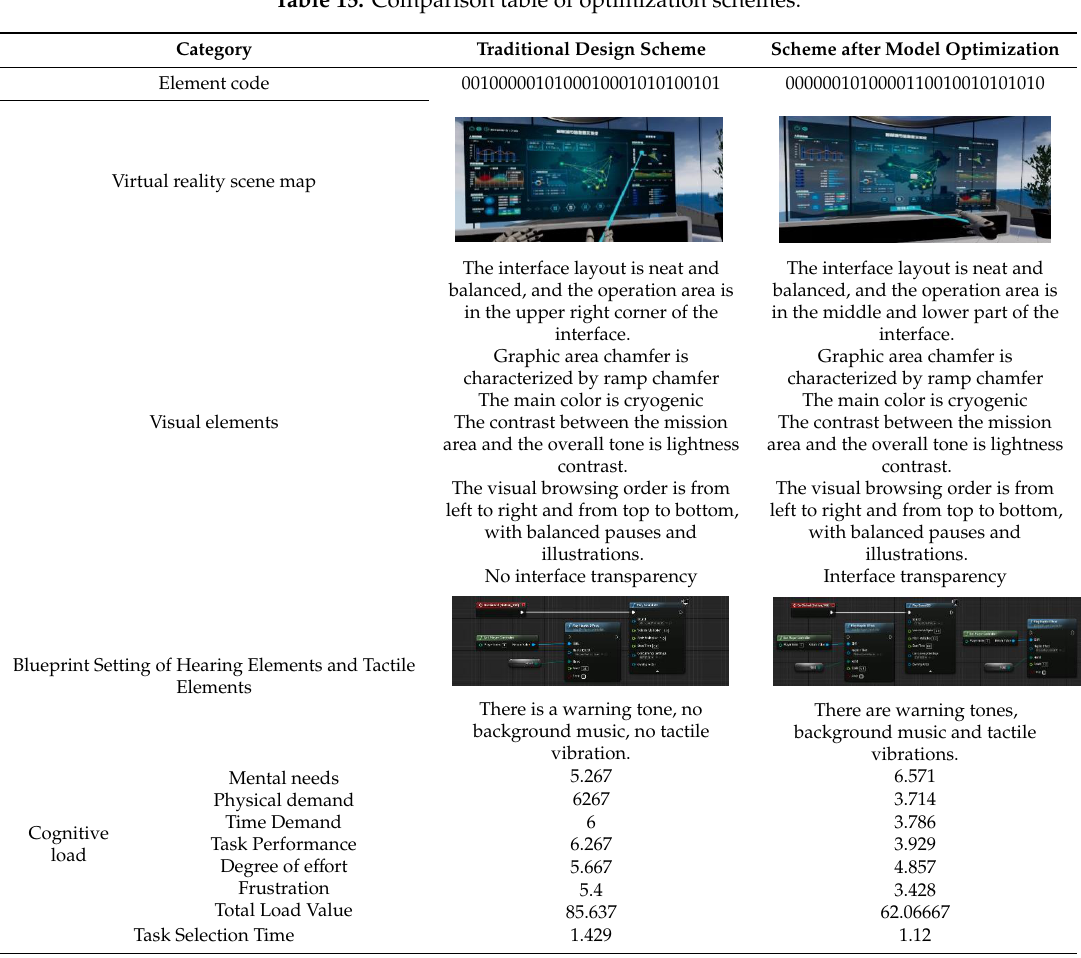
Table 15. Comparison table of optimization schemes.